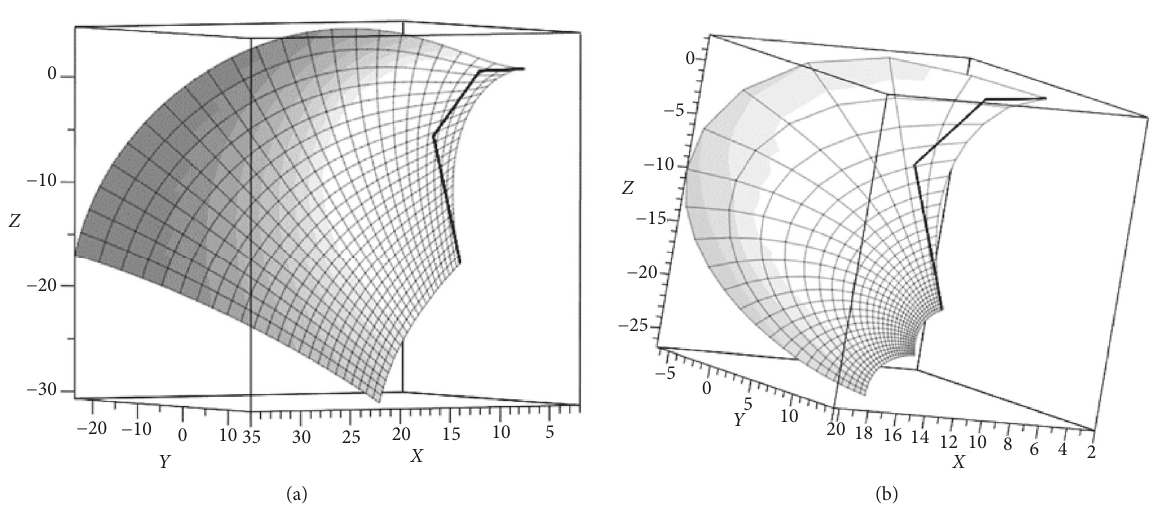
Figure 5: Minimal surfaces built with different weights. (a) The first case. (b) The second case. The reference points are connected by broken bold